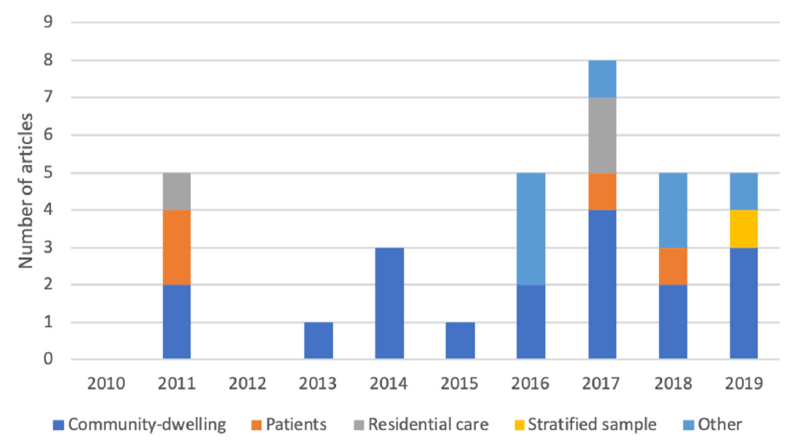
Figure 2. Number of studies per study population and publication year.